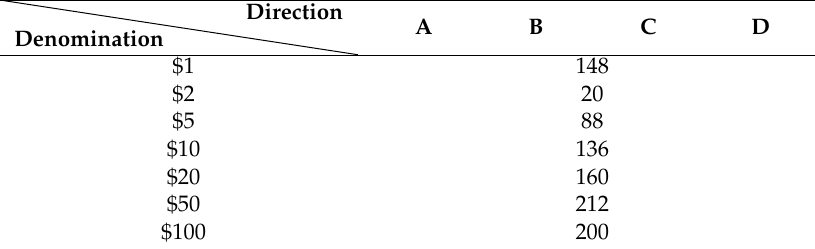
Table 3. Total number of images in the US dollar database used in experiments.